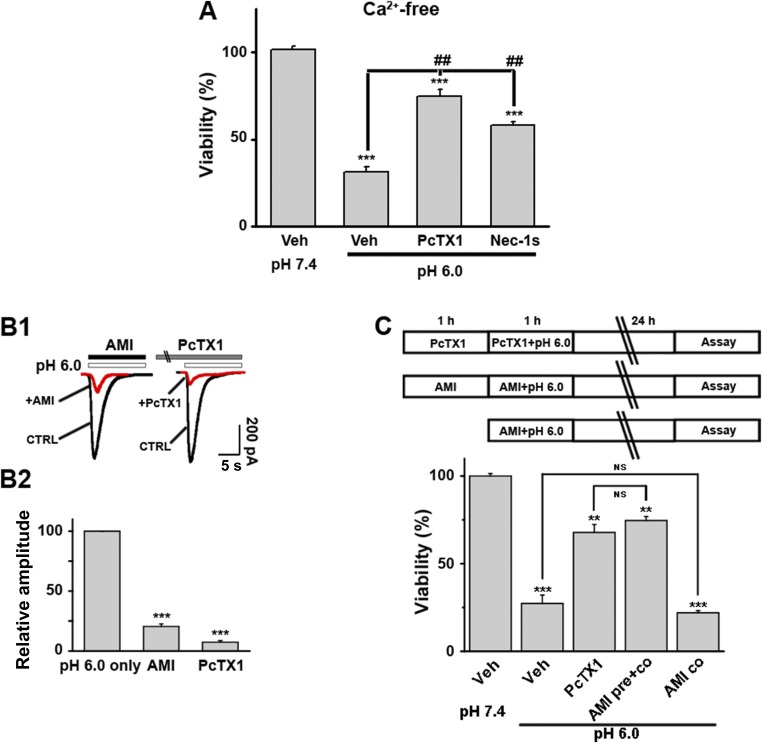
Acid-induced neuronal death is independent of Ca2+-flux and ionic currents via ASIC1a.(A) PcTX1 and Nec-1s rescued acid-induced neuronal death in the Ca2+-free solution (CTB assay, n=3–5, ***p<0.001, vs vehicle (Veh) at pH 7.4; ##p<0.001, vs Veh at pH 6.0). (B1, B2) Inhibition of I6.0 by AMI (100 µM) and PcTX1 (10 nM) in cultured mouse cortical neurons. AMI was applied together with acid. PcTX1 was applied 60 min before acid. Both greatly suppressed I6.0. Shown are representative current traces at −60 mV (B1) and summary data for peak currents (B2) (n=4–6, ***p<0.001 vs pH 6.0 only). (C) Upper, scheme of AMI, PcTX1, and acid (pH 6.0) treatment of cortical neurons. Lower, summary data for neuronal death under the conditions indicated (CTB assay, n=4–6, **p<0.01, ***p<0.001 vs pH 7.4). AMI pre+co: AMI pretreatment plus AMI co-application with acid (pH 6.0); AMI co: AMI co-application with acid (pH 6.0).